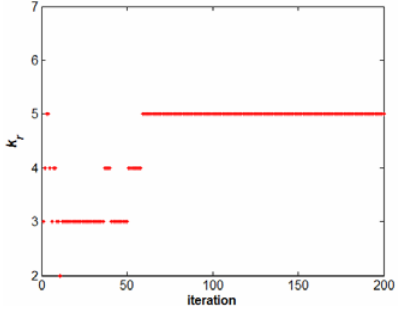
Figure 2. Changes of k r during